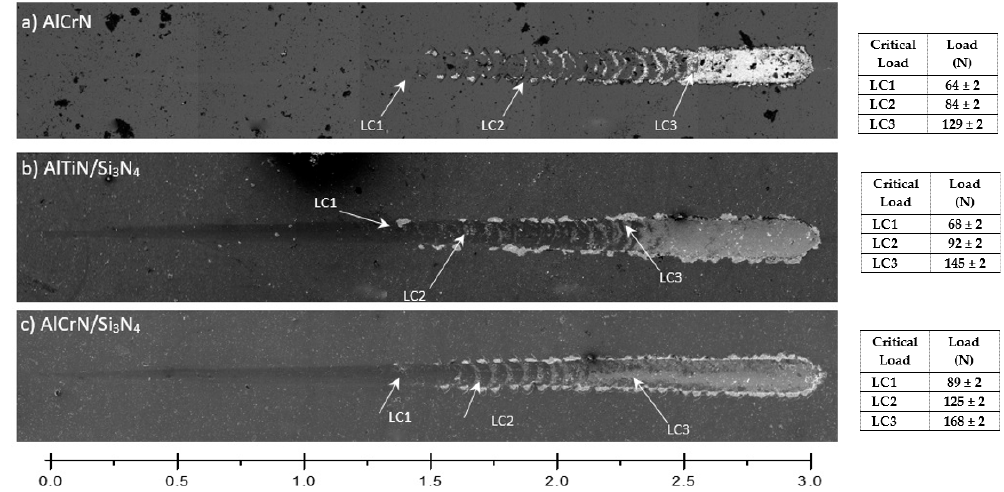
Figure 6. SEM micrographs after scratch test of the coated studied and the Critical load measured at the three stages LC1—First Critical Load (Cohesive Failure); LC2—Second Critical Load (Adhesion Failure) and LC3—Third Critical Load (Substrate Exposure): ( a ) AlCrN; ( b ) AlTiN/Si 3 N 4 ; and, ( c ) AlCrN/Si 3 N 4 .